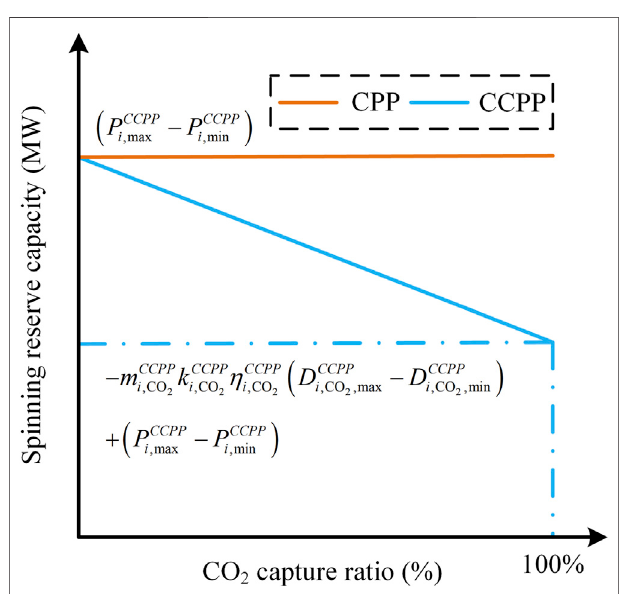
FIGURE3| Relationship between spinning reserve capacity and carbon capture ratio.